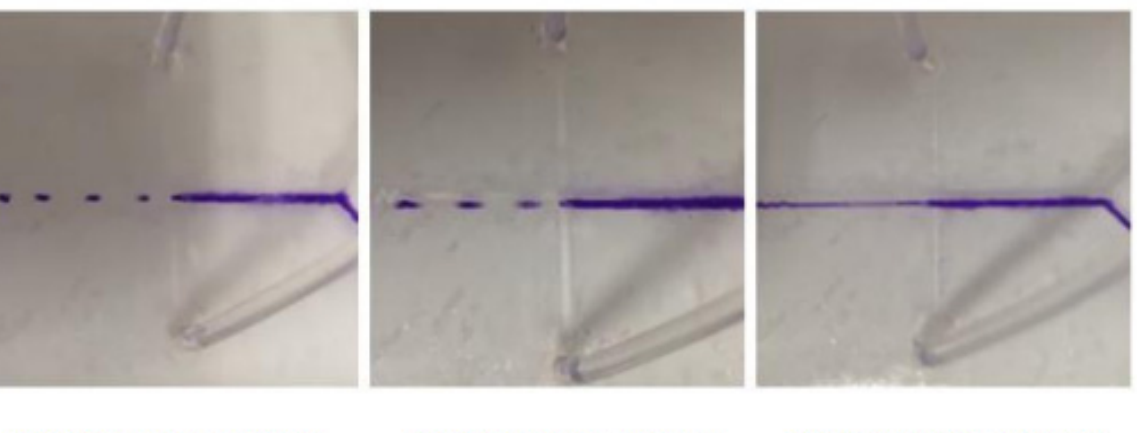
Figure 12. The experimental results of flow rate of the continuous phase being constant and the flow rate of the dispersed phase changing